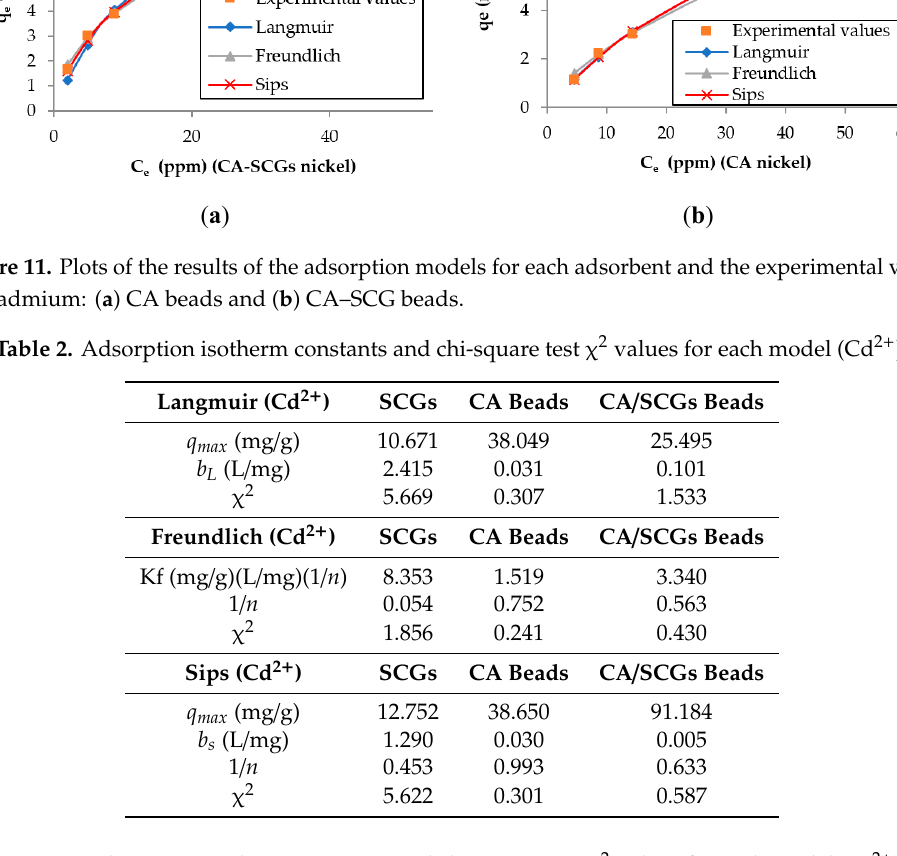
Table 3. Adsorption isotherm constants and chi-square test χ 2 values for each model (Ni 2 +